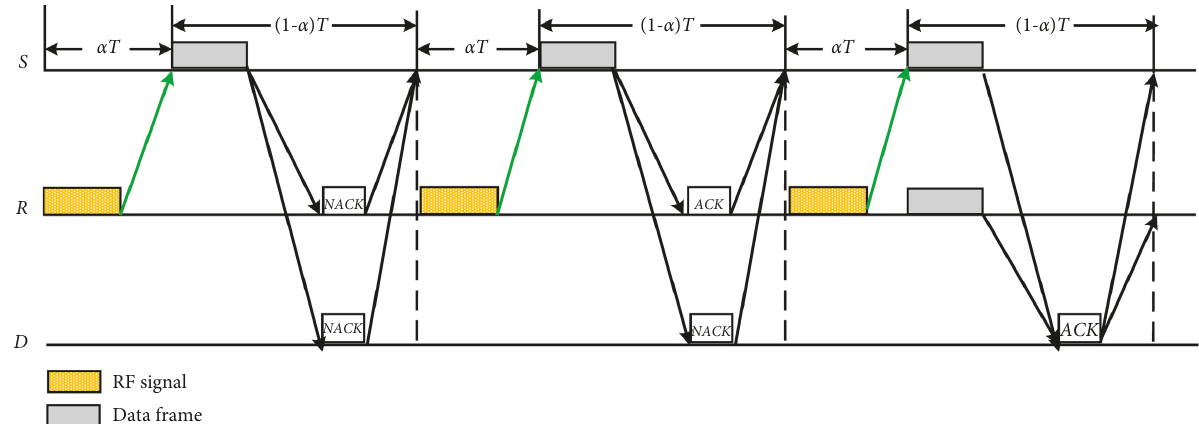
Figure 3: The successful transmission of one data frame for the ECS-HTCARQ protocol in the interference